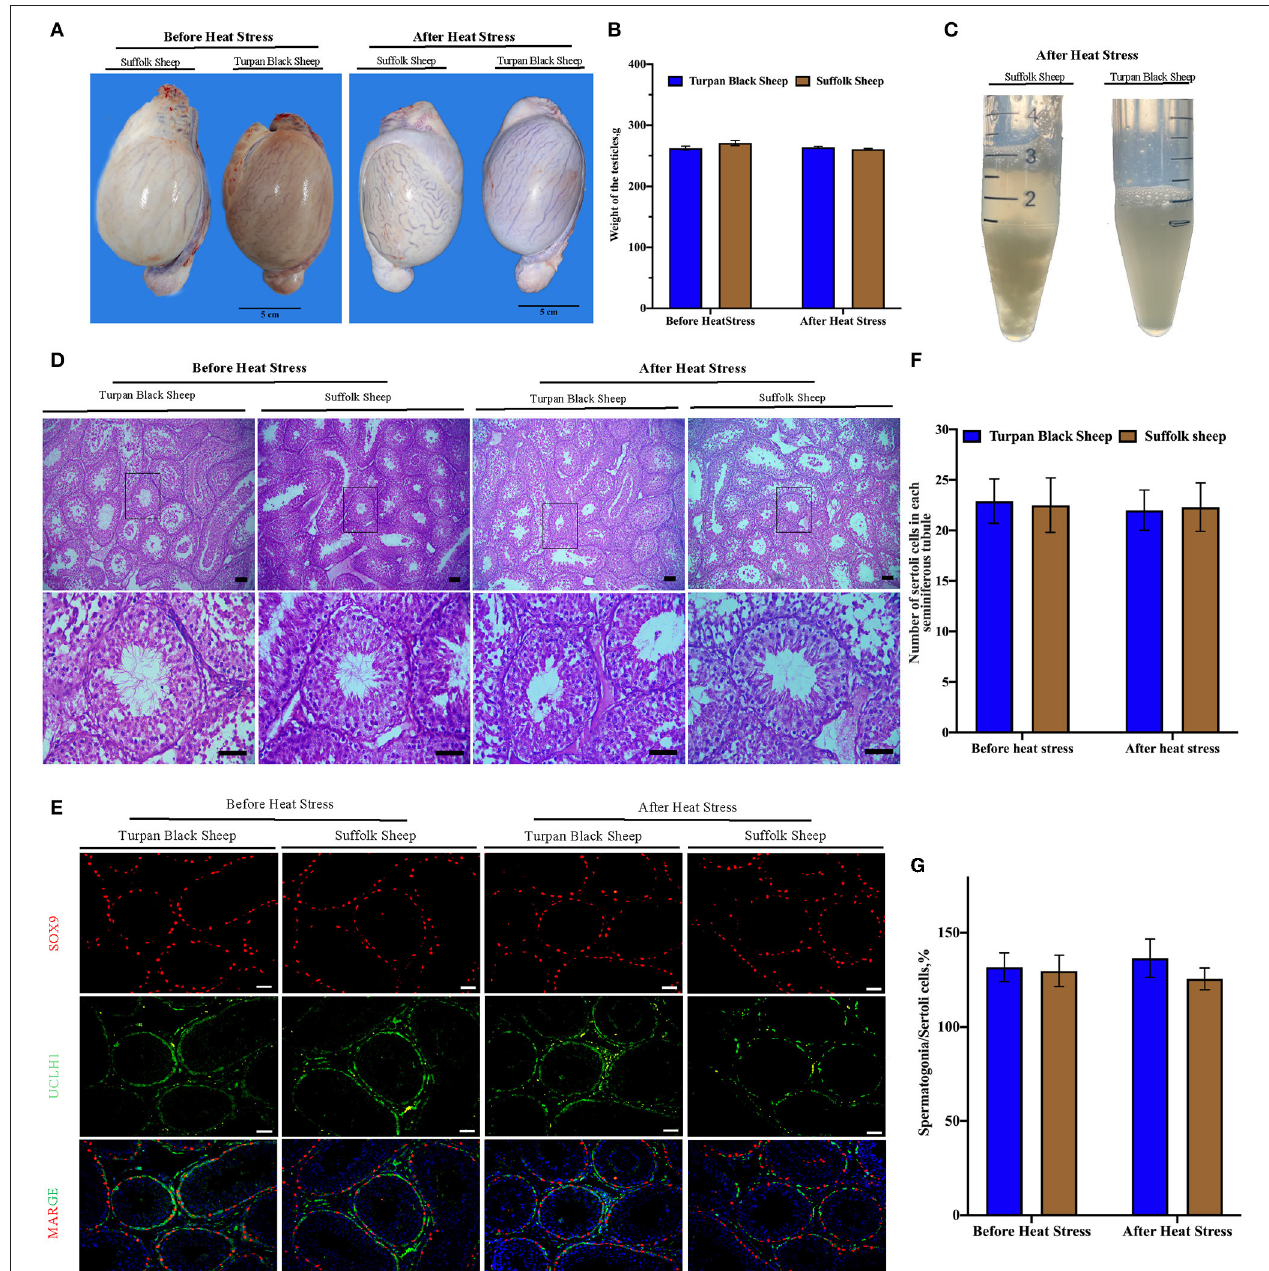
FIGURE 4 | Morphological characteristics of testis and semen after HS. (A,B) Typical testicular images and weight comparison after HS. (C) Semen morphology after HS. (D) Morphological analysis after H&E staining showed that spermatogonial cells, Sertoli cells, spermatocytes, and spermatozoa were arranged orderly in the convoluted tubules of the testis. (E) SOX9 (red fluorescence)-labeled Sertoli cells and UCLH1 (green fluorescence)-labeled spermatogonial cells. (F) Quantitative analysis of Sertoli cells in spermatogenic tubules. (G) The proportion of spermatogonia in 500 Sertoli cells in spermatogenic tubules. Scale = 50 µ m, significance was calculated by T